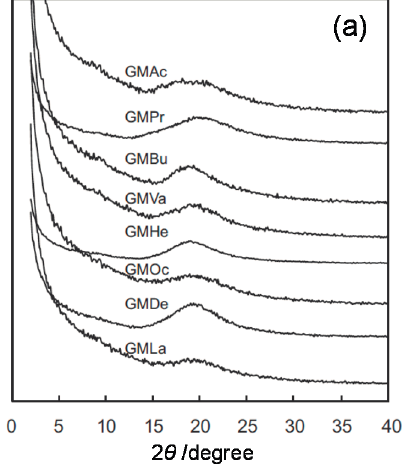
Figure 4. WAXD profiles of chitin and its diester derivatives ( m = 4–20) at 20 °C. Reprinted with permission from ref. [18]. Copyright 2006 American Chemical